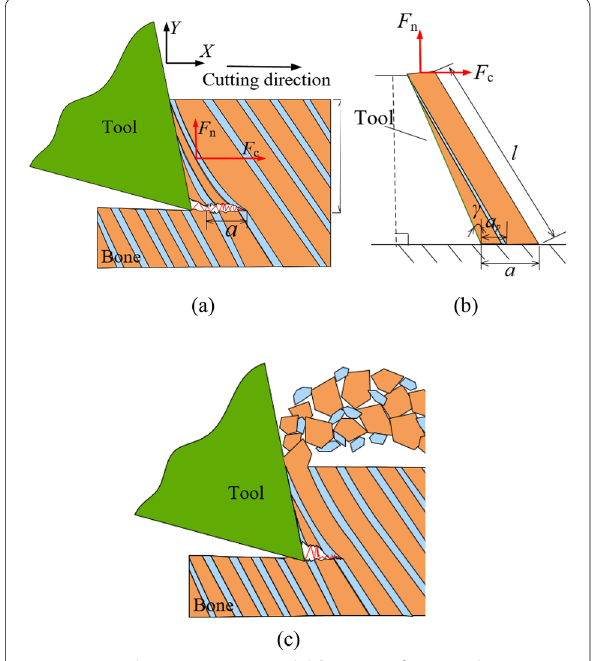
Figure 5 Mode #4: a Cutting model, b Cutting forces on bone osteon and c Predicted chip morphology